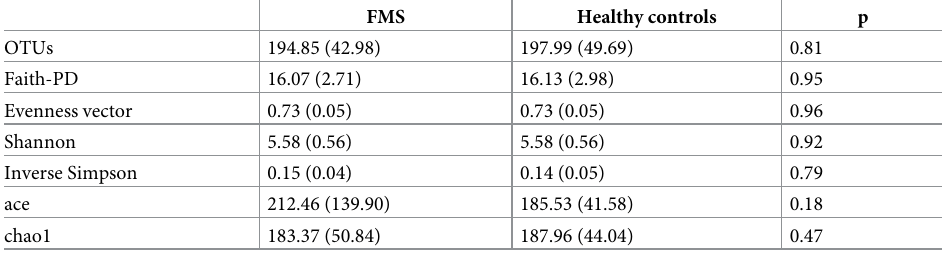
Table 2. Alpha-diversity statistics for the microbiome in FMS patients vs. healthy controls.